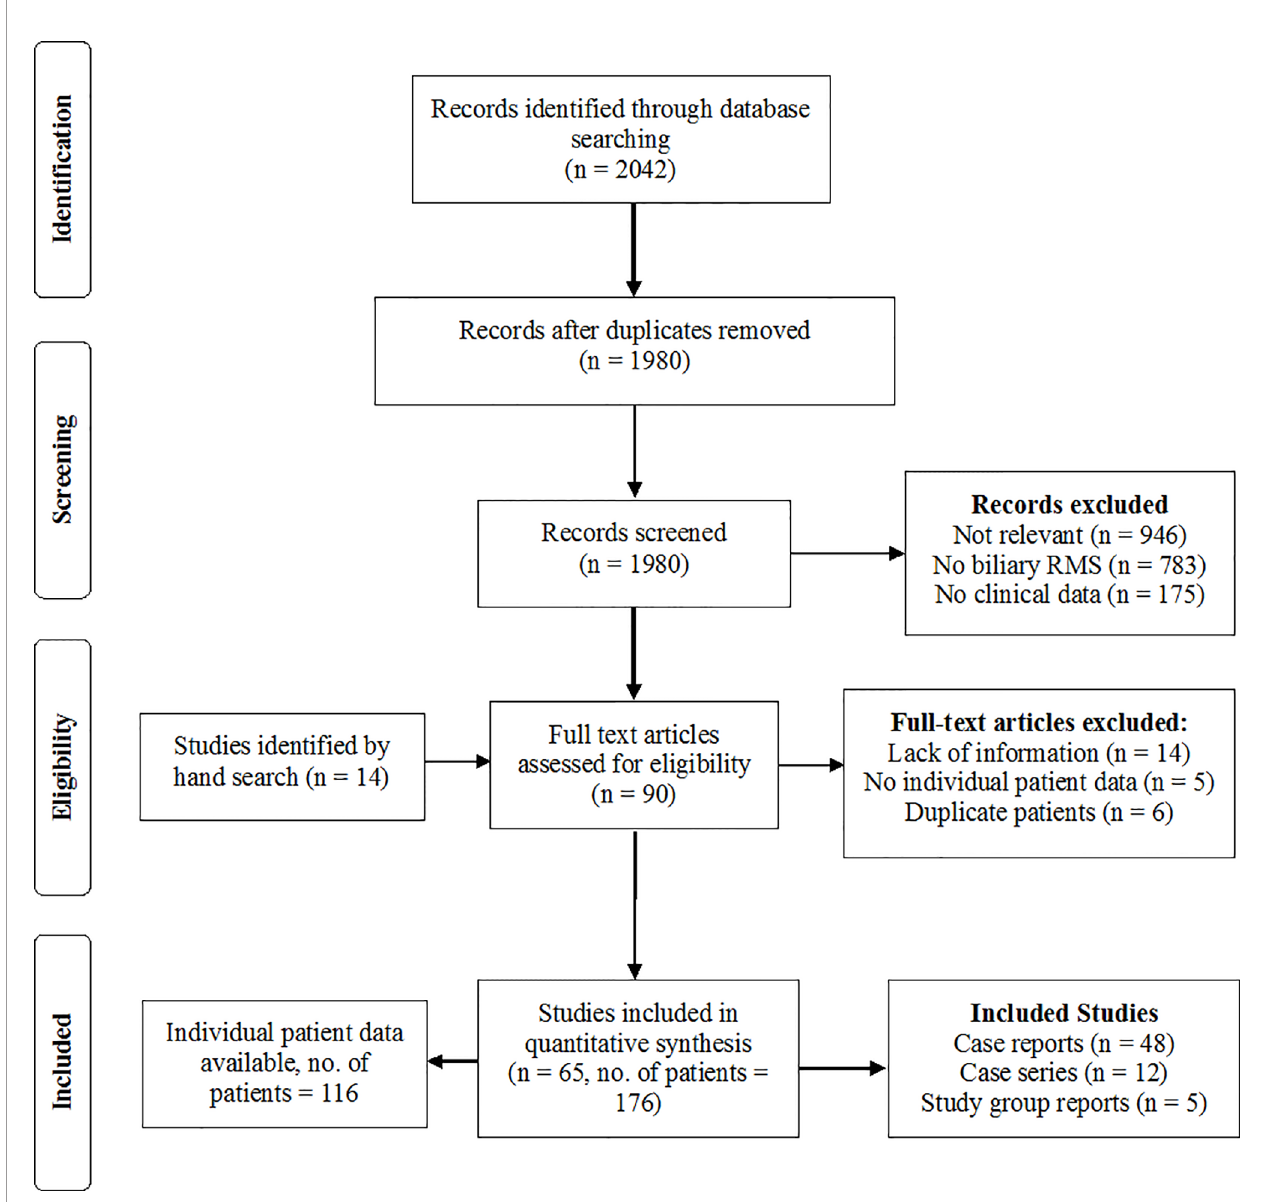
FIGURE 1 | PRISMA fl ow chart of the study selection and inclusion